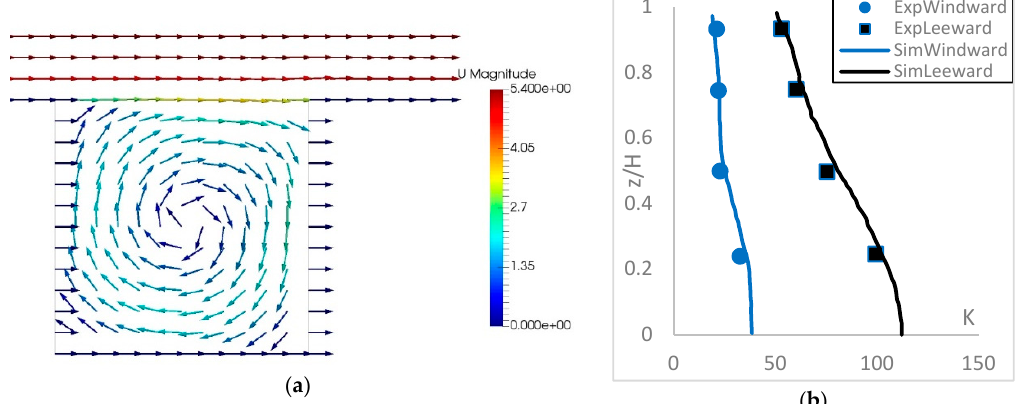
Figure 18. The flow velocity field ( a ), and a comparison of the dimensionless concentration K in the street canyon between simulation and experiments ( b ).